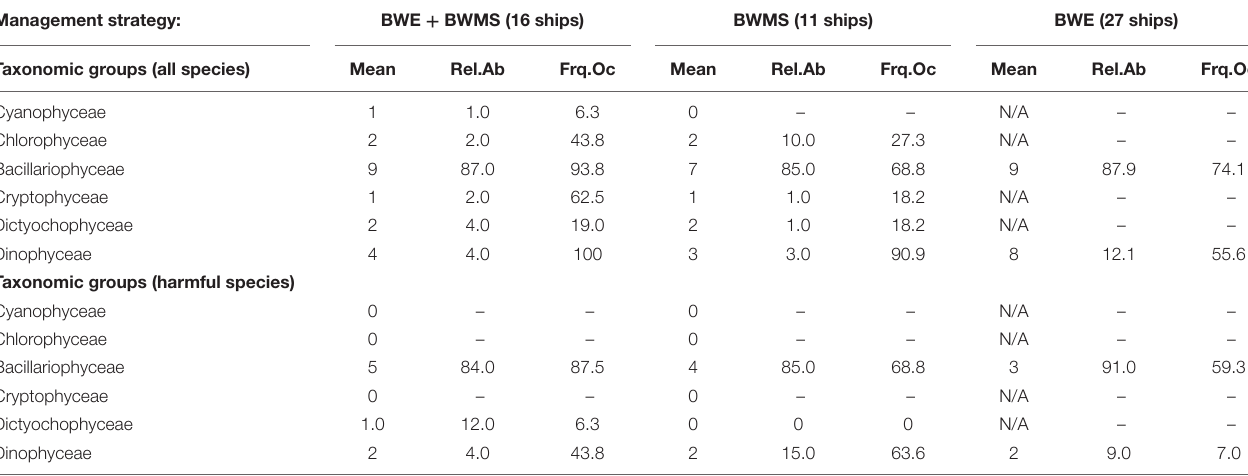
TABLE 3 | Statistics for the mean number of species, relative abundance (%), and the frequency of occurrence (%) of total and harmful phytoplankton identified from ballast water samples, by taxonomic group and management strategy. Management